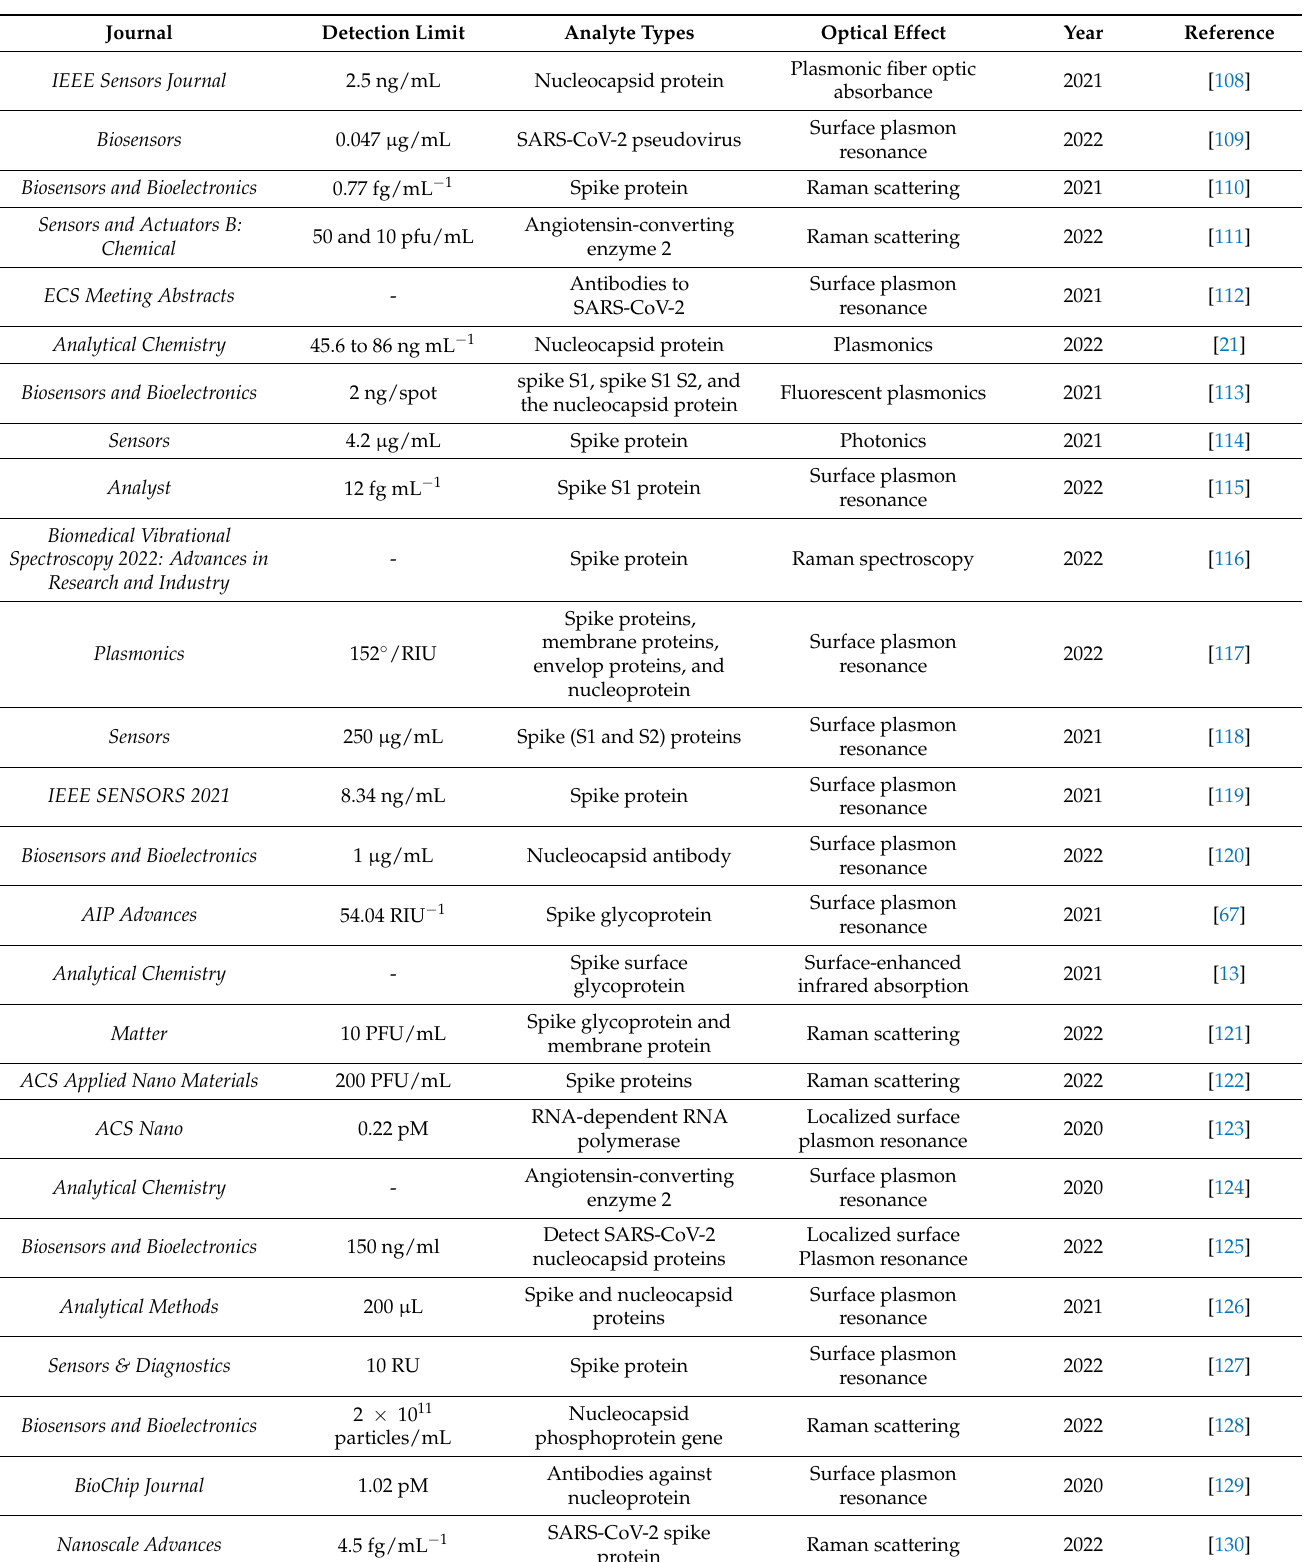
Table 2. Representative multiphoton biosensors papers for the detection of